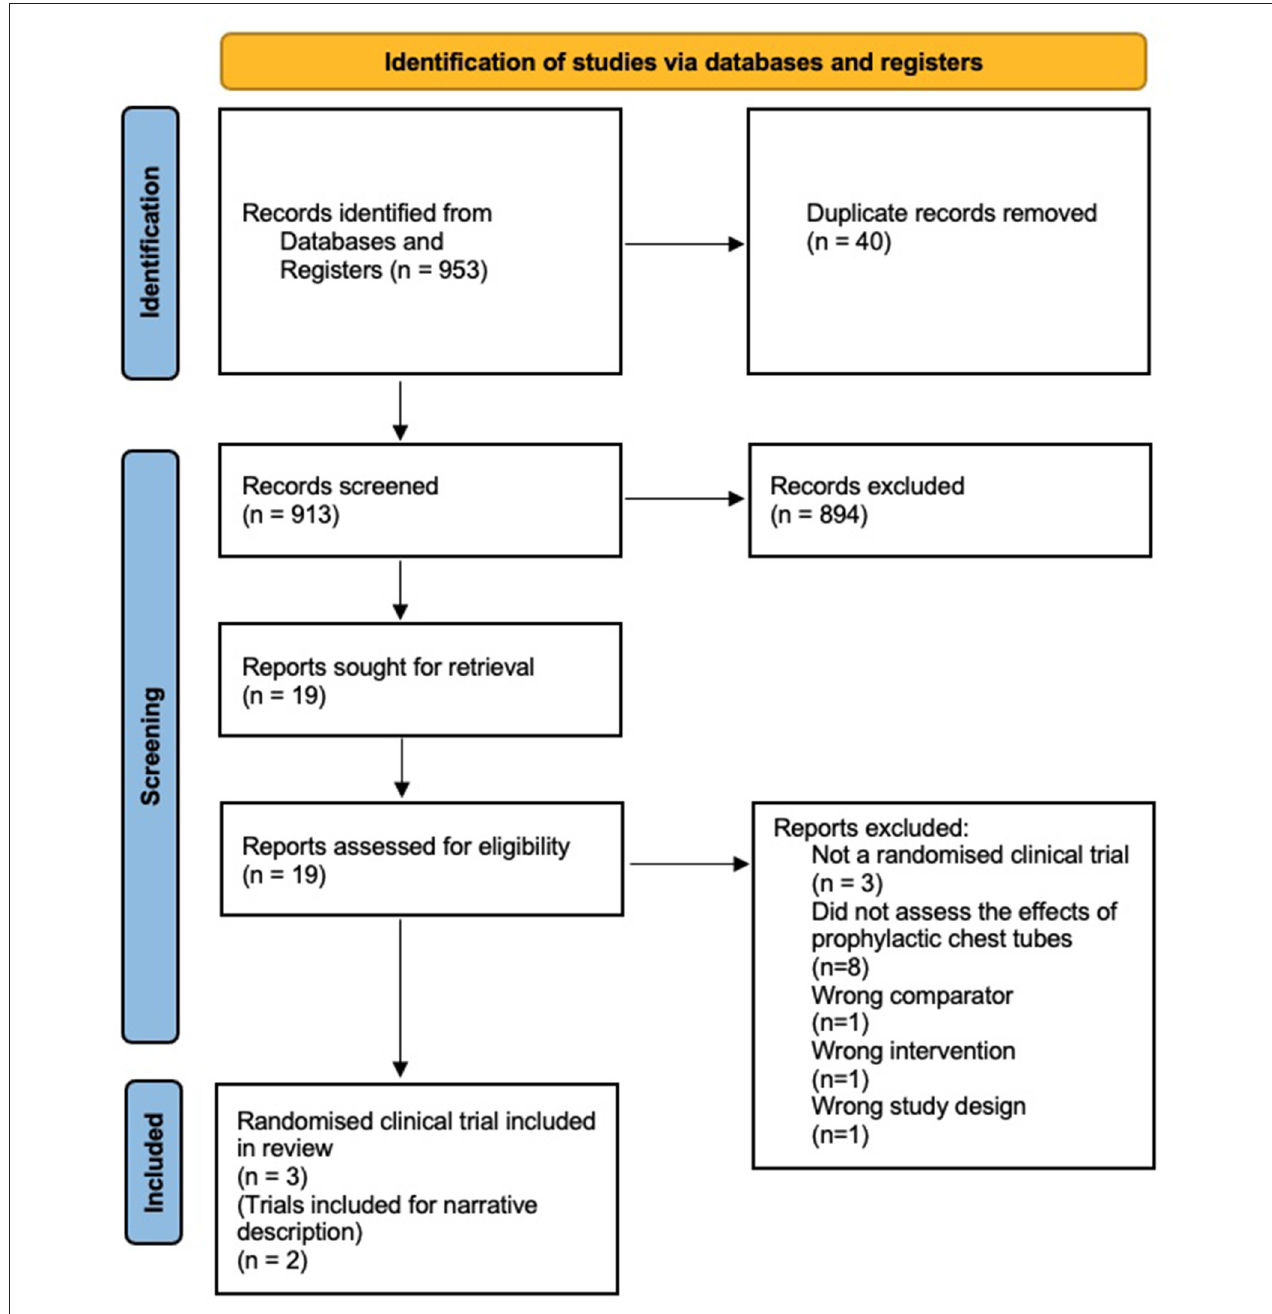
FIGURE 1 | PRISMA